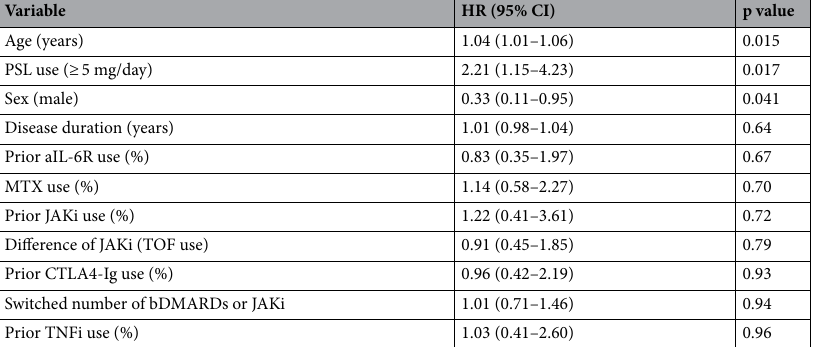
Table 3. Cox proportional hazard analysis for the risk factors of treatment discontinuation due to toxic adverse events. HR hazard ratio, CI confidence interval, PSL prednisolone, aIL-6R anti-interleukin-6 receptor, MTX methotrexate, JAKi Janus kinase inhibitor, TOF tofacitinib, CTLA4-Ig cytotoxic T lymphocyte-associated antigen-4-Ig, bDMARDs biological disease-modifying antirheumatic drugs, TNFi tumour necrosis factor